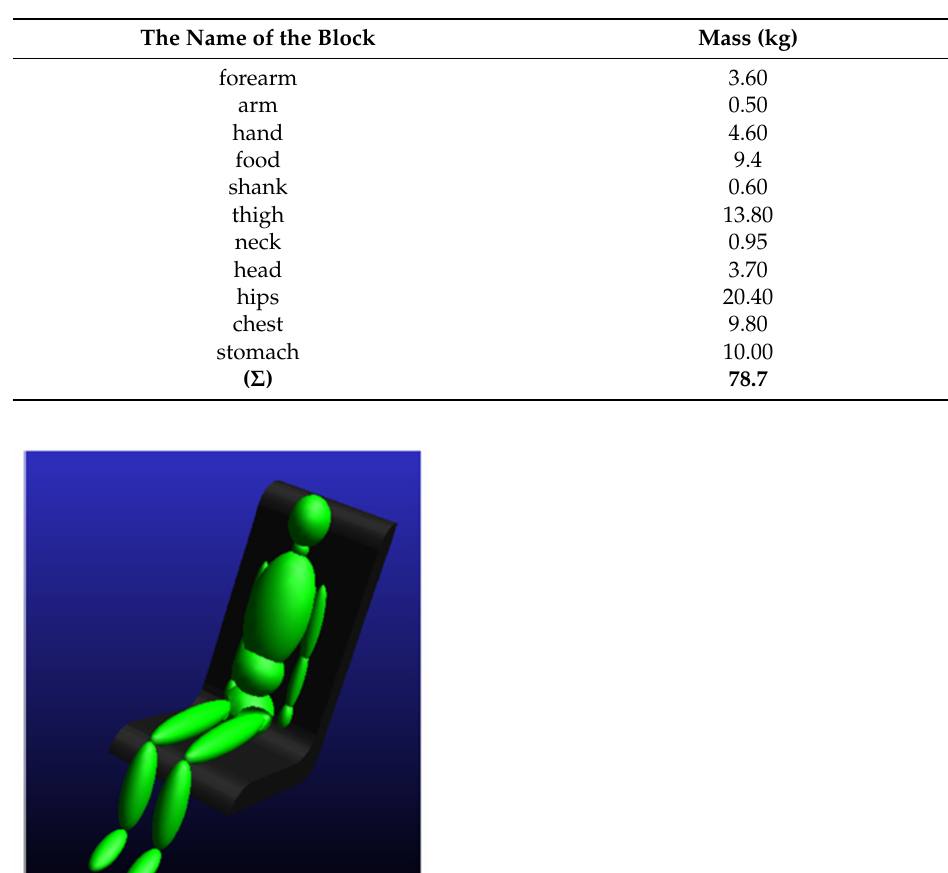
Table 1. The masses of individual body parts of the simulation dummy.